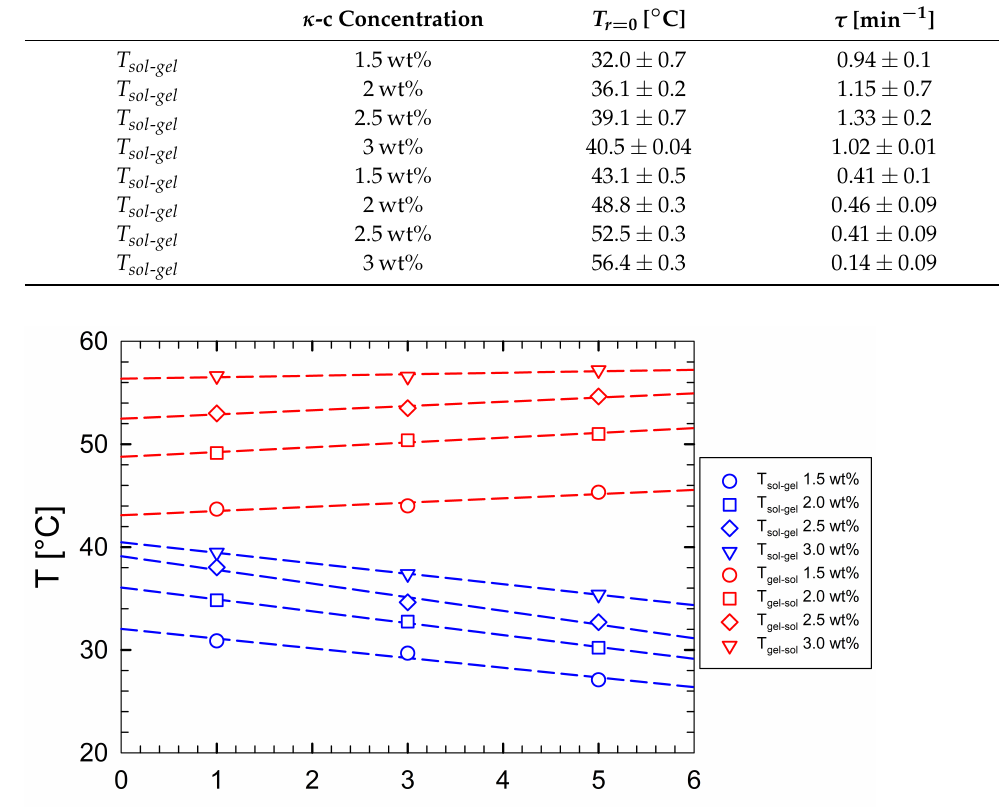
Table 1. Fitting parameters of Equation (2).